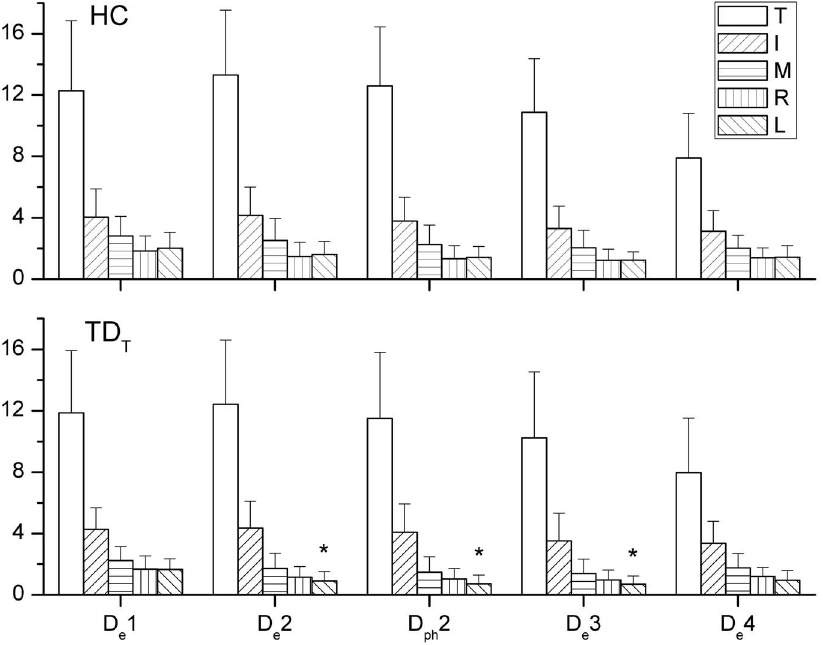
Figure 4. The significant difference of applied RF between TD I and HC during drinking. The RF of each digit at all events and the averaged RF during second phase of the drinking task by HC ( upper ) and TD T ( lower ). Lower forces for the little finger were found at D e 2 and D e 3 and during second phase for TD T than those for HC. Significant differences are indicated by * ( p , 0.05).